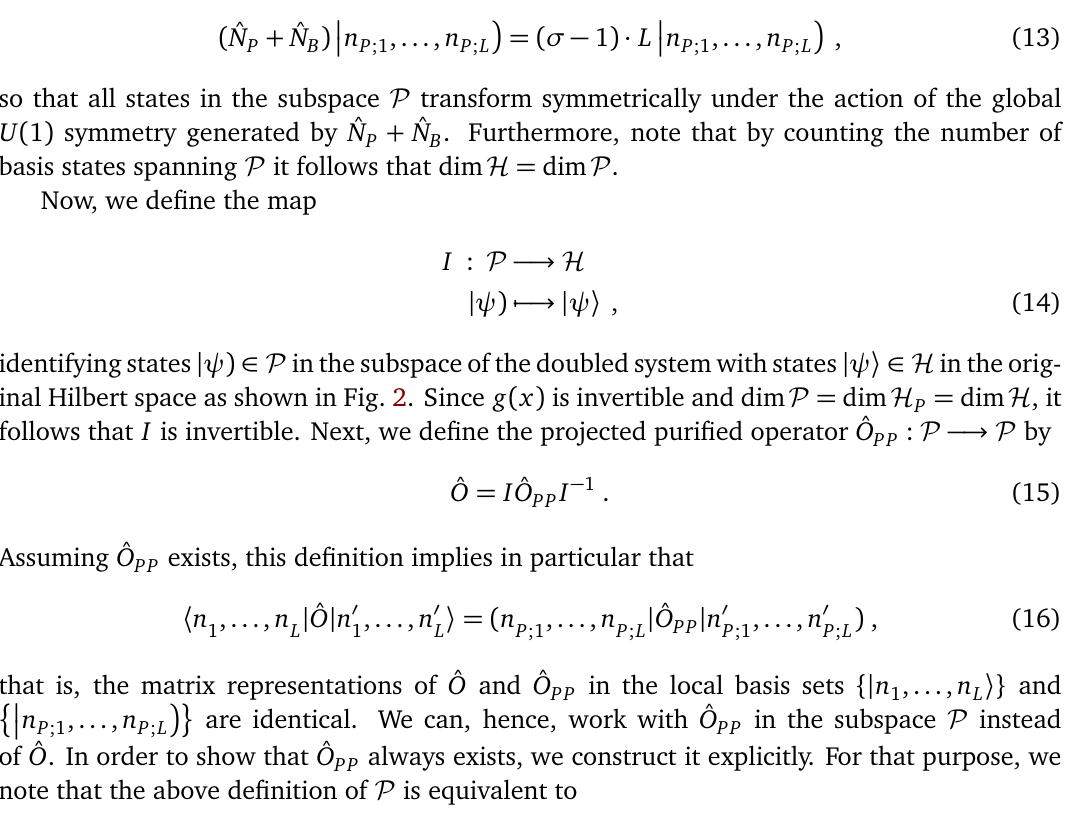
, a thermofield doubling is performed H = ⊗ . Applying the projection as H PB H P H B , in which the global U ( 1 ) symmetry P H